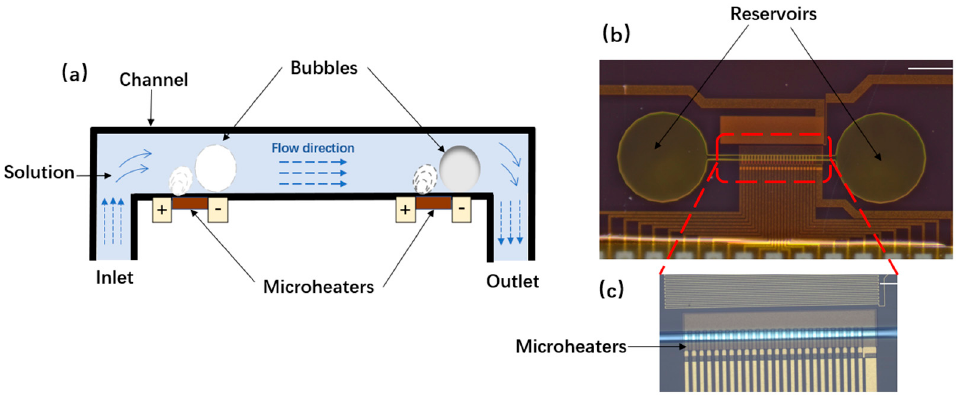
Figure 1. ( a ) Schematic diagram of the micropump. ( b ) Entity graph of heating resistors and micro- pump structure and the (Scale bar: 0.5 μ m). ( c ) The amplified photo of microheater (Scale bar: 0.07 μ m).